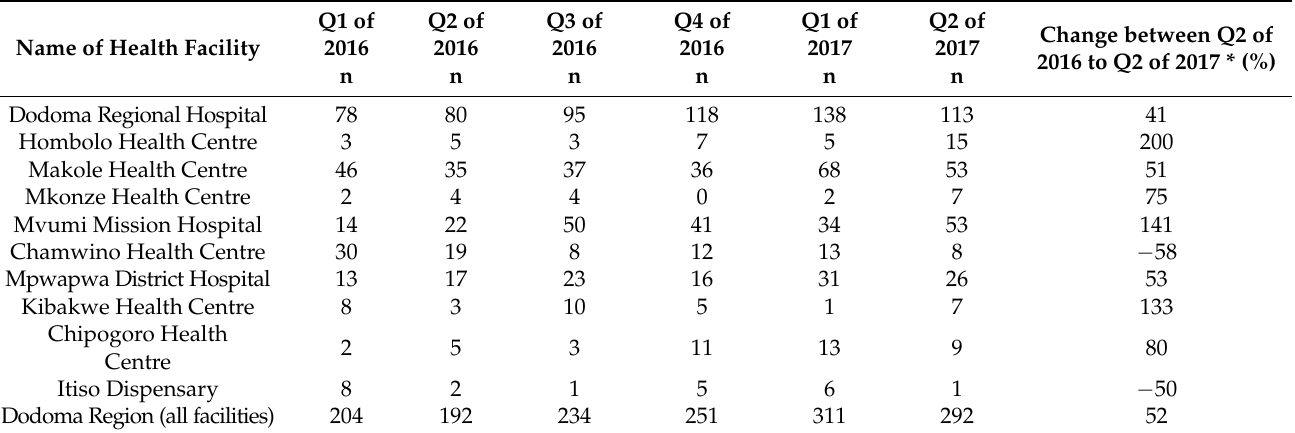
Table 1. Quarterly TB case notification in 10 intervention facilities in Dodoma (Q1 of 2016–Q2 of 2017), Tanzania.